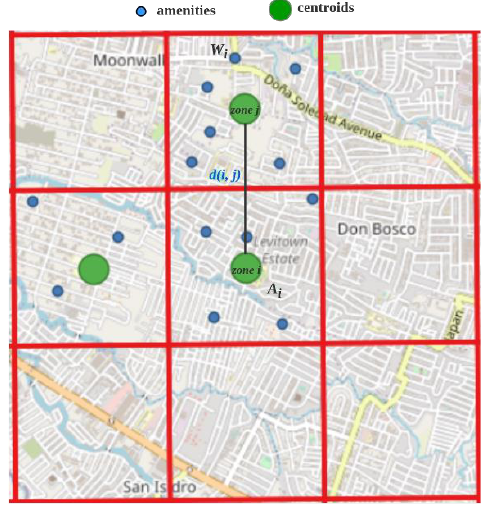
Figure 2 : Illustration of Accessibility Score Measurement The distance 𝑑 𝑖,𝑗 is the calculated great-circle distance between the centroid of each fishnet cell of Zone 𝑖 and all the other zones within a given arbitrary maximum neighborhood distance (as seen in Fig. 2). For this study, it is set to 14.2 km radius from Zone 𝑖 to capture all other zones including centroids in the diagonal. In order to consider the amenities inside the study zone (i.e., when 𝑖 = 𝑗 ), a default distance called self-distance is assigned to prevent having zero distance as the denominator. Self-distance is set to 0.5 km.